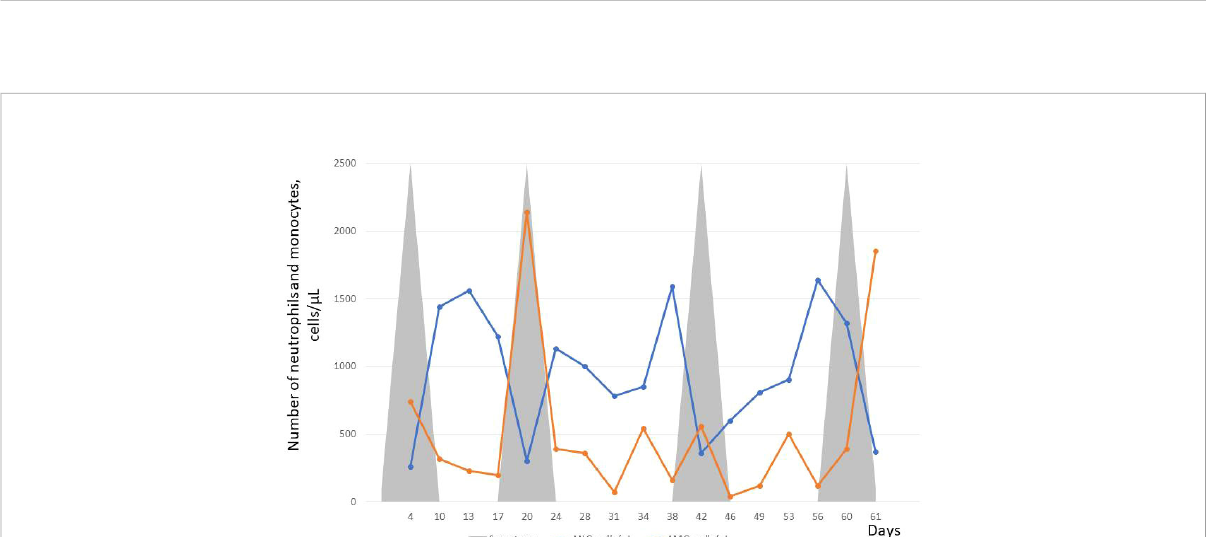
FIGURE 3 Absolute neutrophil count (ANC) and absolute monocyte count (AMC) over a period of 61 days before starting G-CSF therapy. About 20 day ANC cycles are presented by counting cell number at every 3 or 4 days. In contrast, AMC cycling was not observed over time. Rather, compensatory monocytosis were observed during the 2 nd and 4 th neutropenia cycles. Upper and lower respiratory tract infections were observed during each neutropenia cycles shown schematically by grey